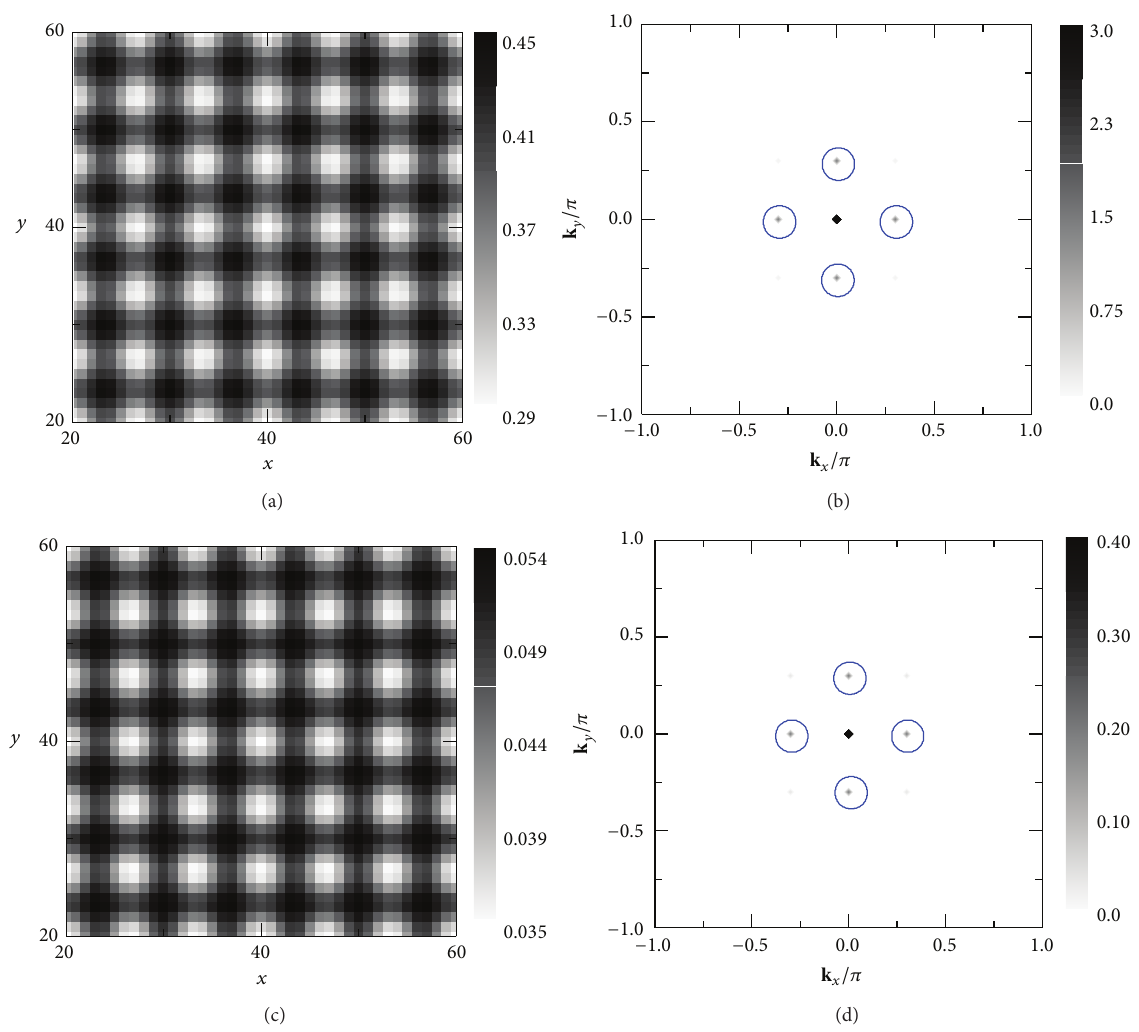
Figure 5: The LDOS [ 𝜌 i (𝜔) ] and FT-LDOS [ 𝑍( q ,𝜔) ] in the normal state and superconducting state with 𝑉 = 0.1 and 𝜔 = 0.1 . (a) LDOS in the normal state with Δ = 0 . (b) FT-LDOS in the normal state. (c) LDOS in the superconducting state with Δ 0 = 0.25 . (d). FT-LDOS in the superconducting